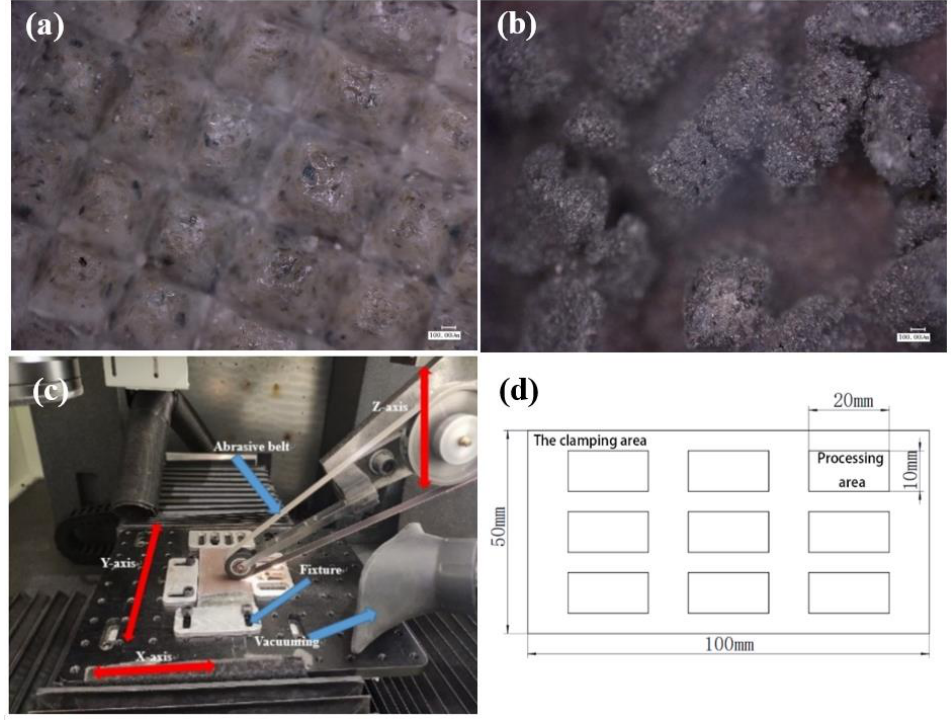
Figure 1. ( a ) for 3M abrasive belts and ( b ) for VSM abrasive belts; ( c ) specimen grinding and ( d ) grinding area.